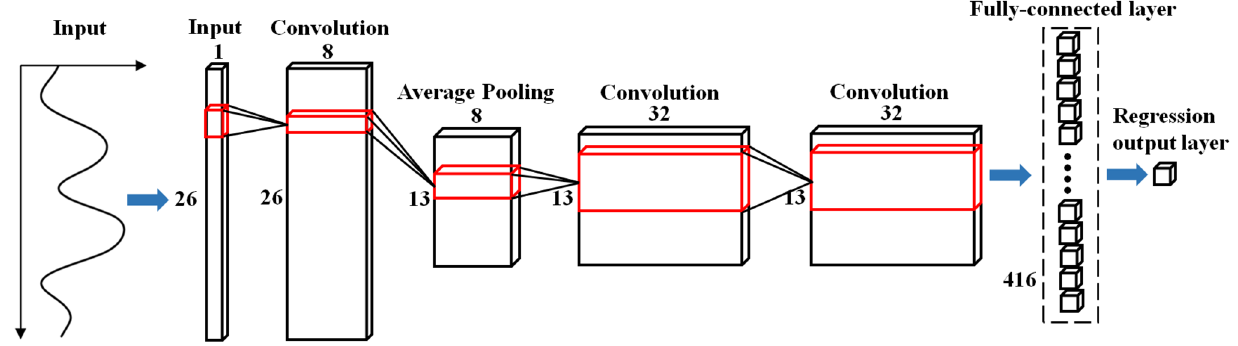
Figure 4. Architecture of the 1-D CNN model used in this